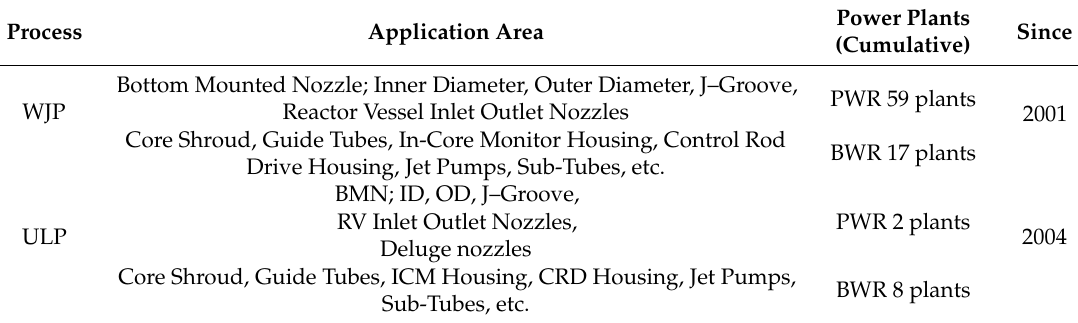
Table 1. Application of the advanced surface modification process in